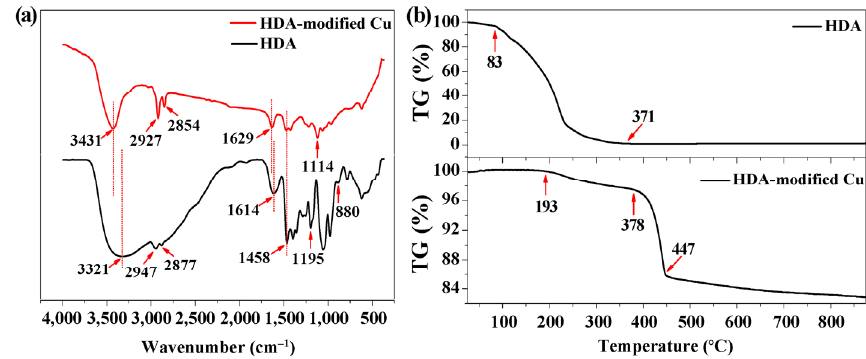
Fig. 5 (a) FT-IR spectra and (b) TGA curves of HDA and water-soluble Cu